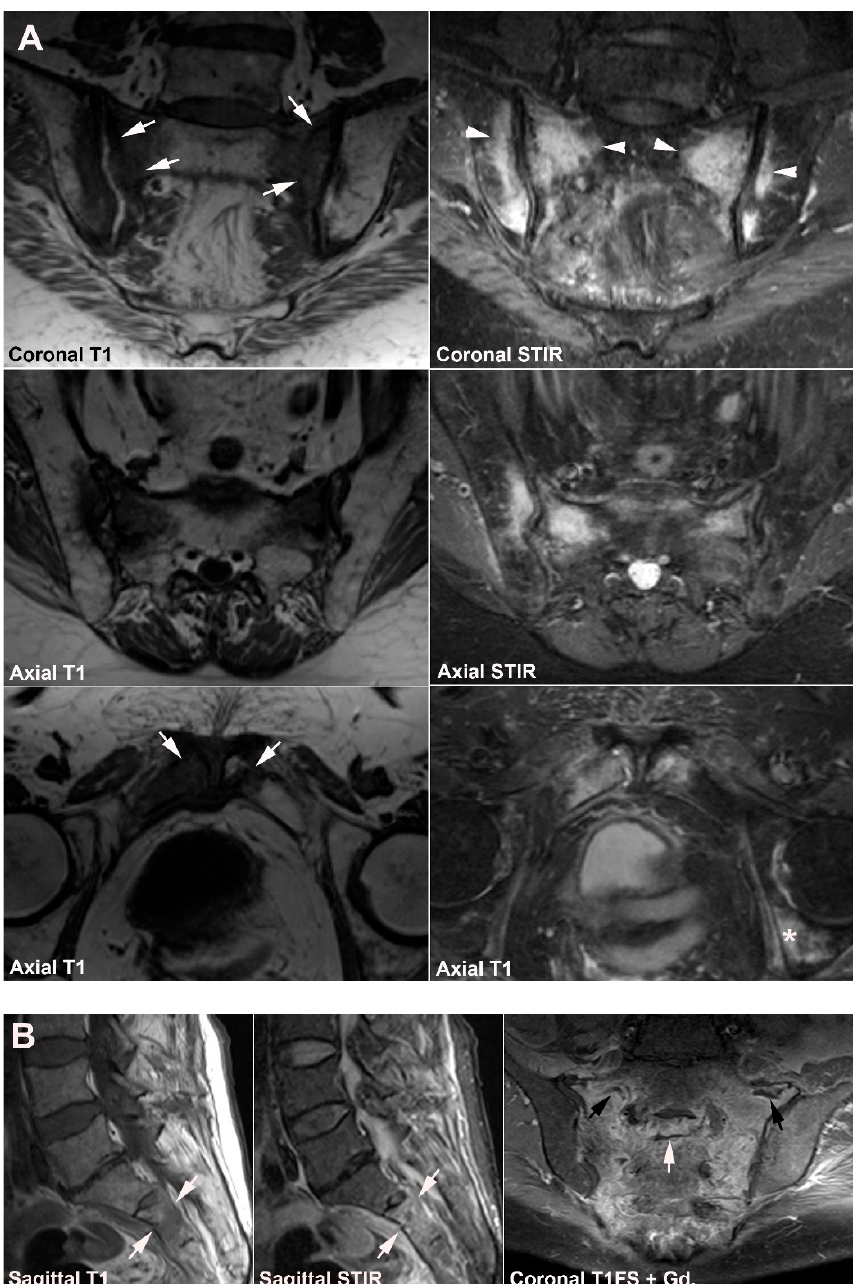
Figure 25. Insufficiency fracture after pelvic irradiation due to gynecological malignancy. ( A ) MRI in an 82-year-old woman with low back and left-sided hip pain, semi-coronal and semi-axial T1 and STIR of the SIJ (two upper image rows) in addition to semi-axial T1 and STIR of the symphysis (lower image row) showing bilateral fracture lines in the sacrum (arrows) with pronounced surrounding BME and subchondral BME in the ileum, most pronounced on the right side (arrowheads). There is a concomitant bilateral fracture in the pubic bones likewise with pronounced surrounding edema and BME posteriorly at the acetabulum (asterisk) indicating an insufficiency fracture. ( B ) MRI in a 75-year-old woman, sagittal T1 and STIR of the sacrum and postcontrast semi-coronal T1FS showing pronounced a diffuse enhancement of the sacrum with fracture lines laterally (black arrows) in addition to a transverse fracture in the upper part of S2 visible on the coronal image, but more easily detectable on the sagittal images (white